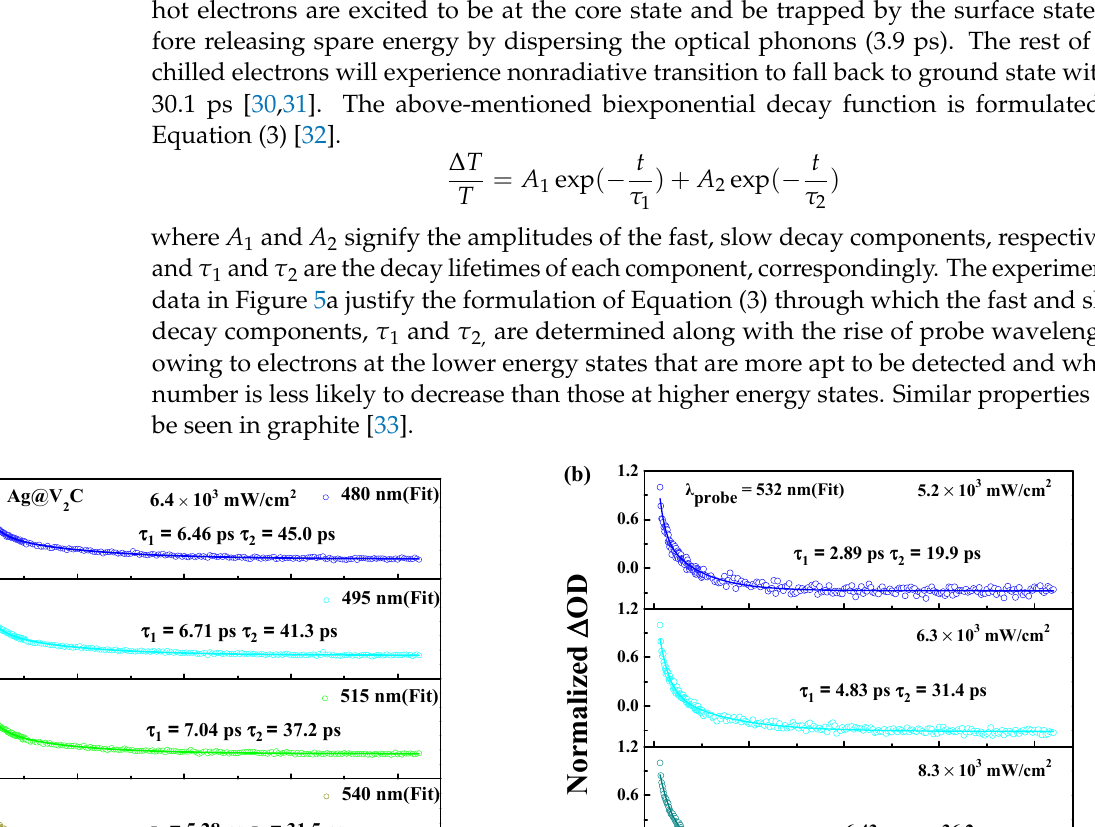
Table 2. Carrier dynamics parameters of the Ag@V 2 C nanosheet.